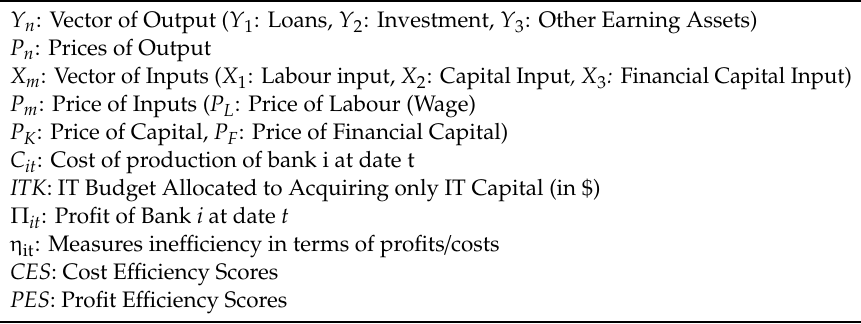
Table 2. Choice and labelling of variables.